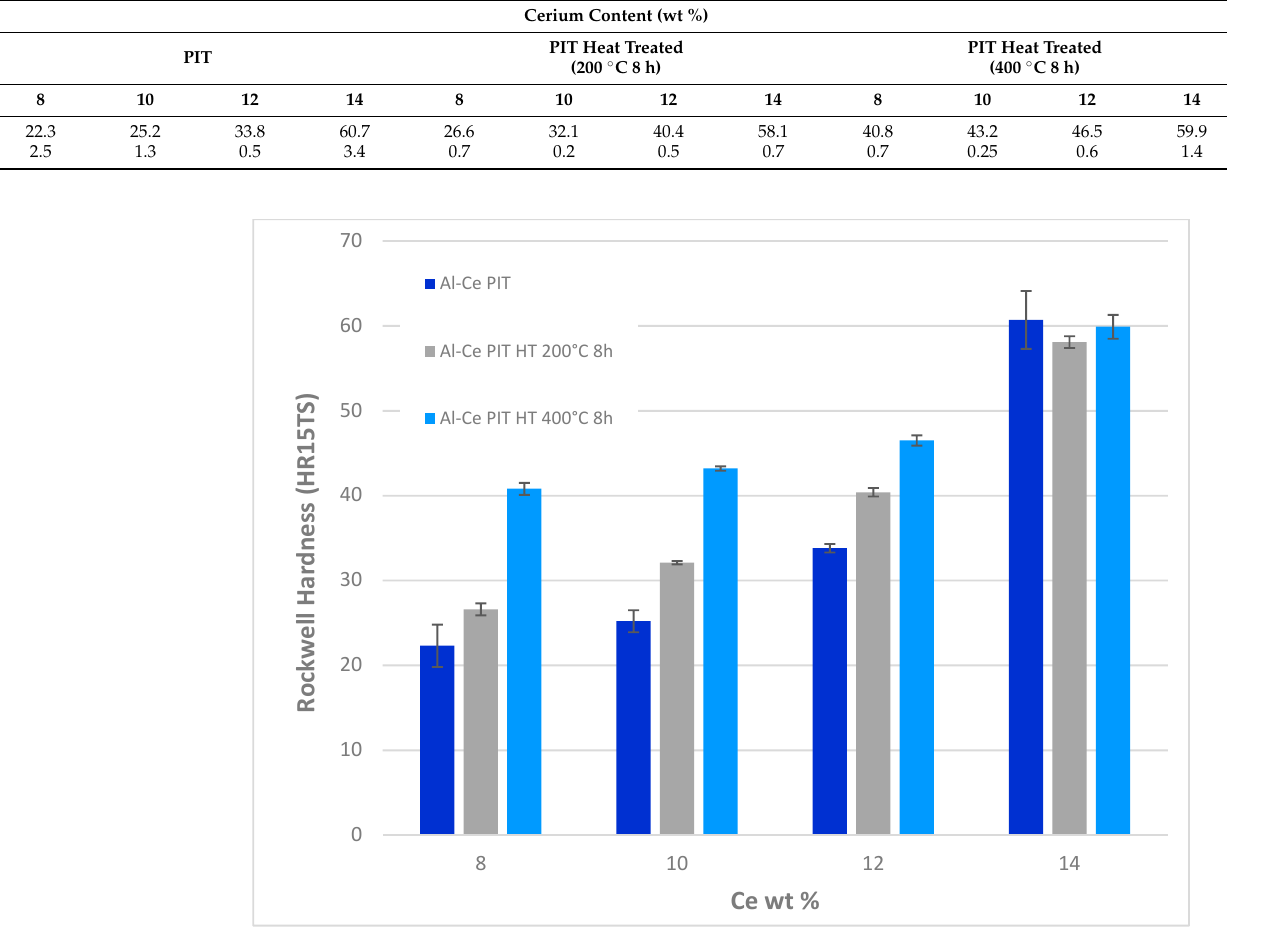
x Ce PIT reacted powder